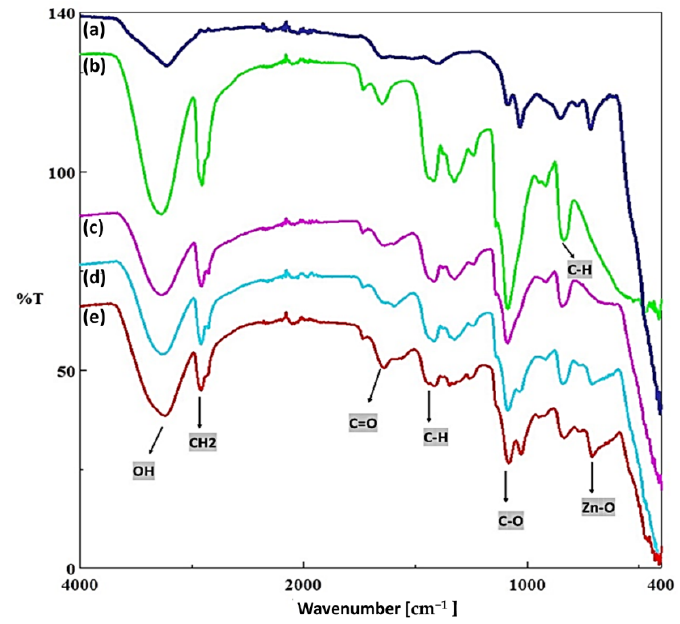
Figure 2. FT-IR spectrum of pure PVA, ZnO NPs, and PVA/ZnO composite nanofibers. ( a ) ZnO NP, ( b ) PVA fibers, ( c ) PVA/20%ZnO NPs solution, ( d ) PVA/40%ZnO NPs solution, and ( e ) PVA/60%ZnO NPs solution.